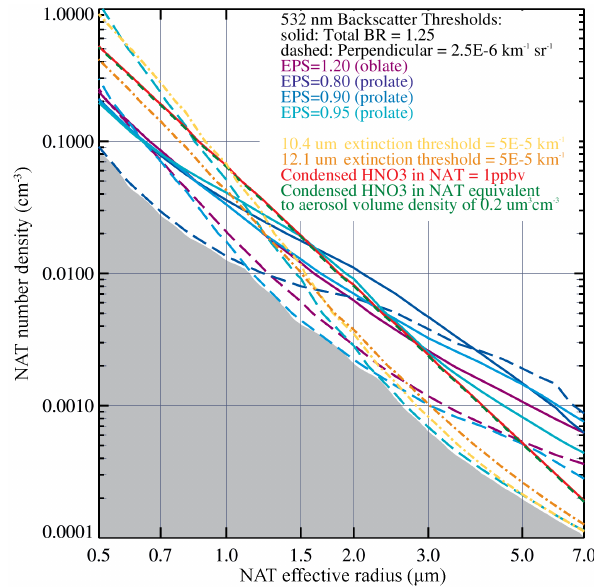
Figure 6. Intercomparison of the sensitivity of various PSC detec- tion techniques to a range of NAT number densities and effective radii at a temperature of T − T ICE = 5K, for an ambient pressure of 46hPa, 5ppmv H 2 O, and 12ppbv total HNO 3 . The purple–blue lines indicate the limits of detection for lidar with total backscat- ter (solid) and orthogonal channel (dashed) for a range of aspect ratios (EPS). The red (green) line indicates the sensitivity of an in situ sampling instrument to 1ppb of condensed HNO 3 in NAT (aerosol density, 0.2µm 3 cm − 3 ) or the equivalent uptake from the gas phase (e.g., by a microwave limb sounder). Yellow/orange lines indicate the sensitivities in the mid-infrared for a limb sounder at two wavelengths. NAT PSCs with particle distribution characteris- tics lying within the gray shaded region are undetectable by any of the above techniques, with the assumed horizontal and vertical averaging scales given in the